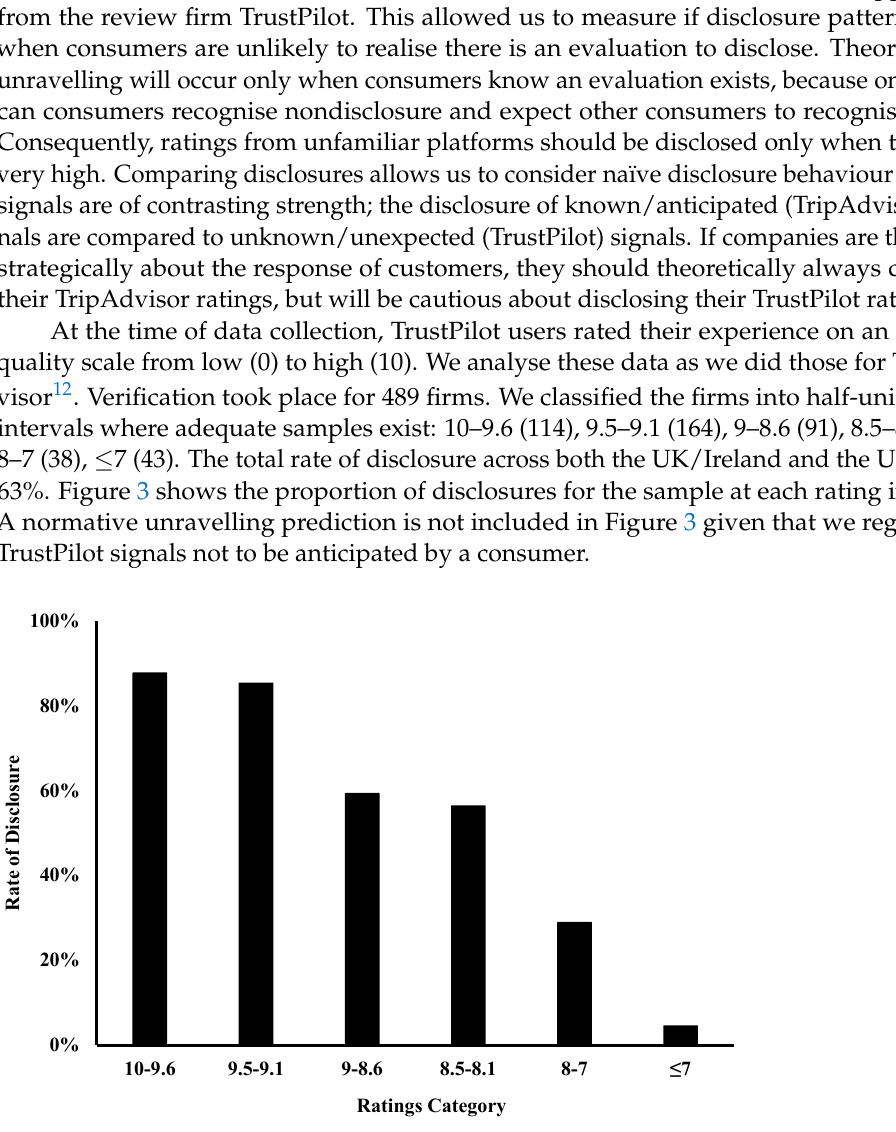
Figure 3. Rating Disclosures by Trustpilot